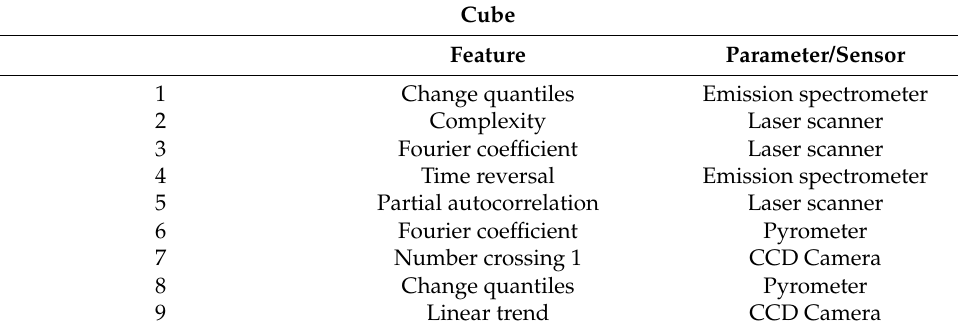
Table 4. Relevant features for cube categorization.